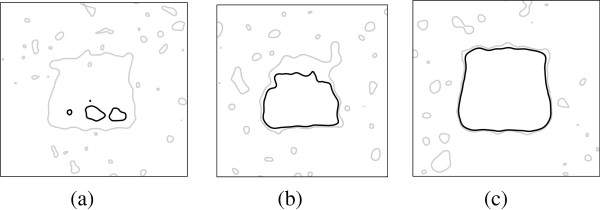
The identified region with p < 0.05, through a voxel-by-voxel based t-test (gray contour) and the permutation test (black contour), given the number of patients of (a) n = 5, (b) n = 50 and (c) n = 100.